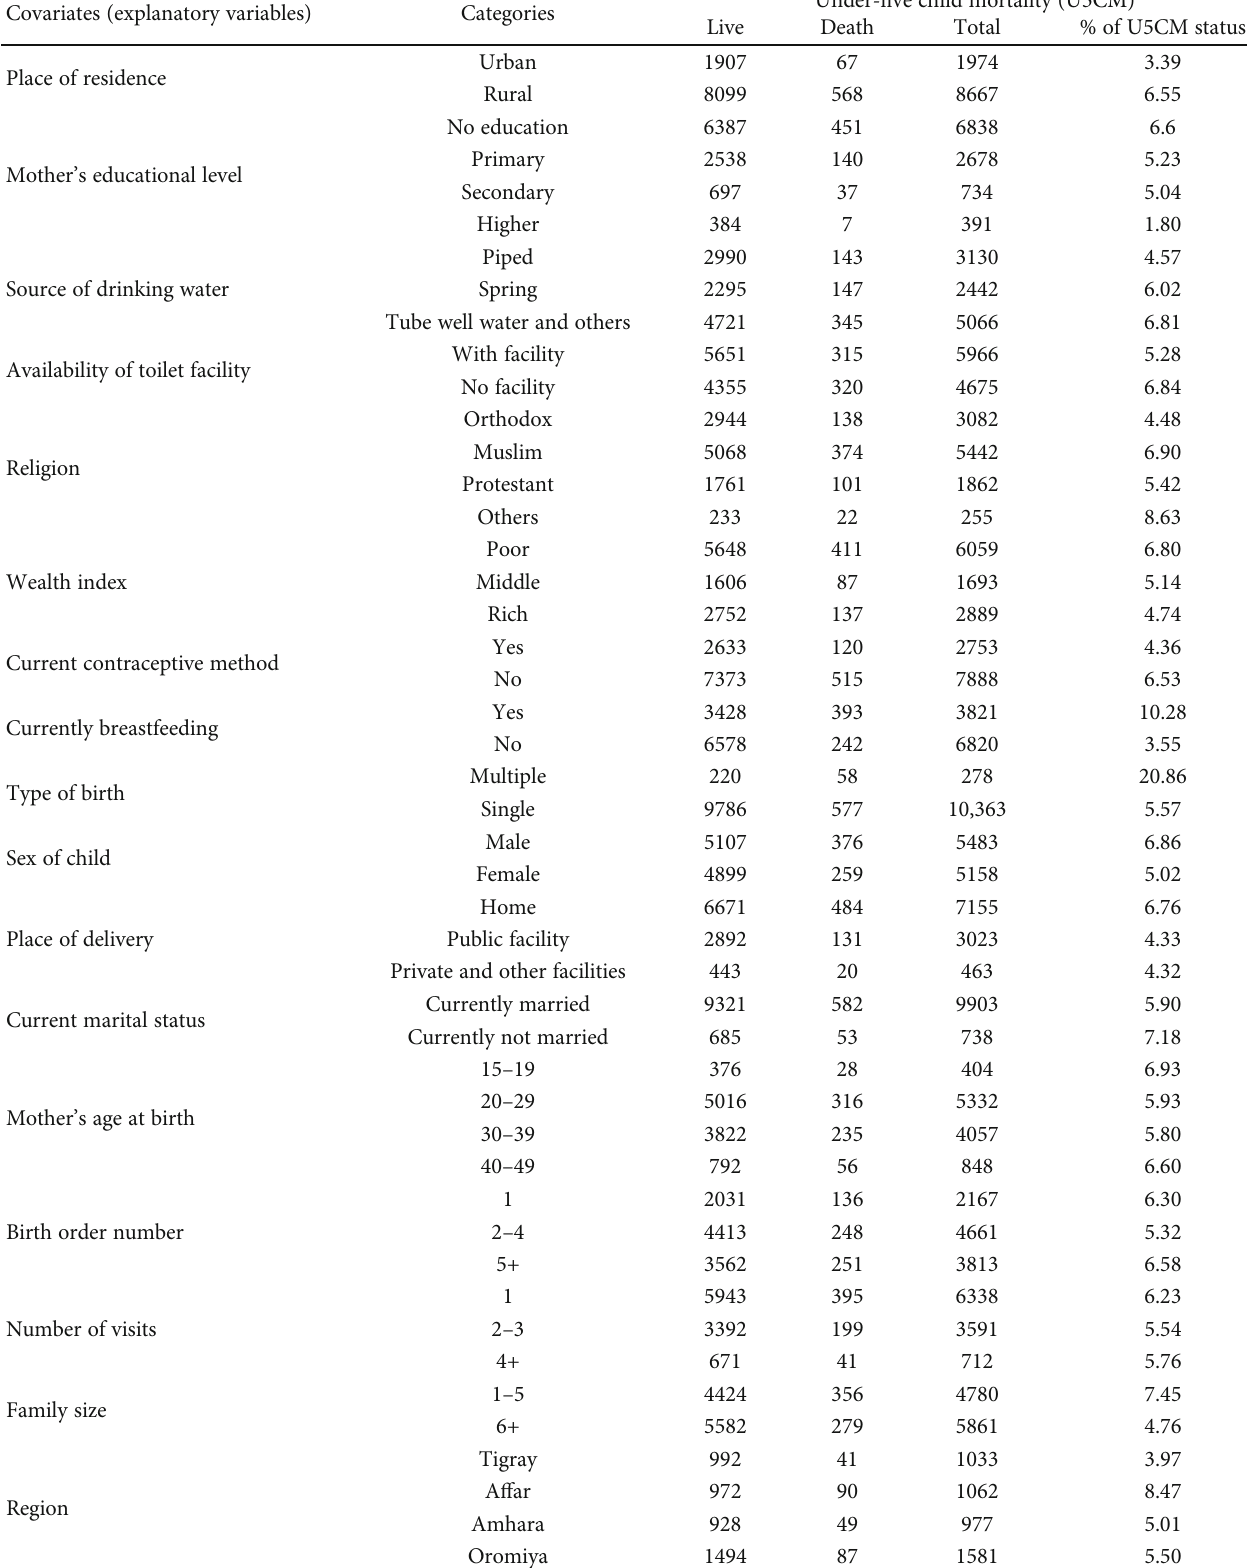
Table 2: The distribution of child mortality by socioeconomic, biodemographic, environmental, and maternal health care variables in Ethiopia,